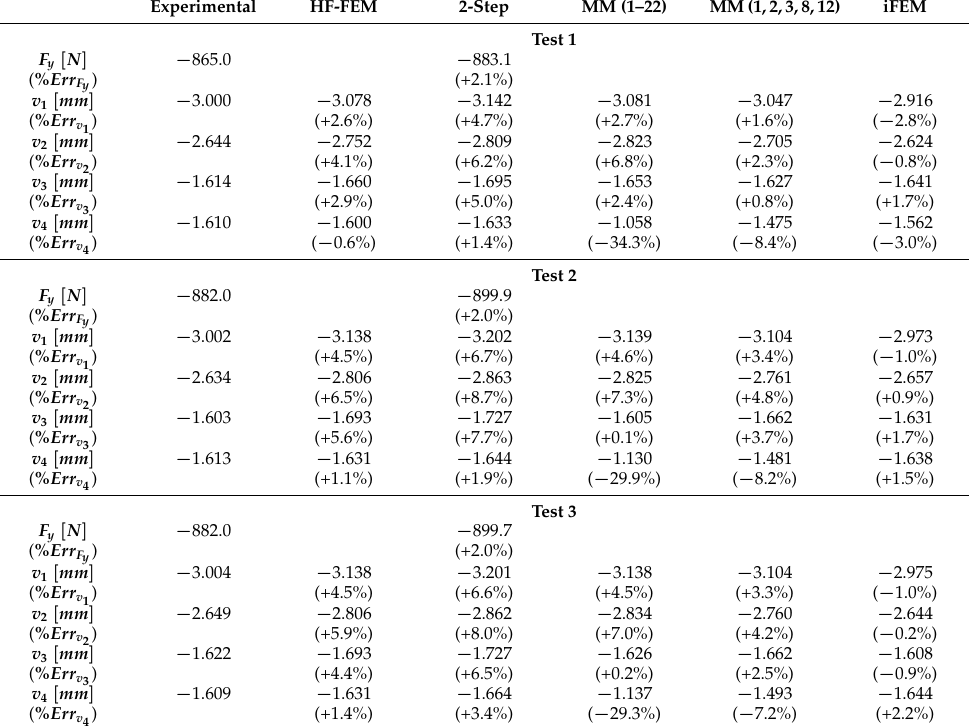
Figure 9. LVDTs’ configuration—The location of the four LVDTs ( v 1 − 4 ) on the surface of the panel are shown. All dimensions are expressed in [mm]. Table 2. Shape sensing and load identification results for the stiffened panel. In parenthesis, the per- centage errors with respect to the experimental values are reported. The errors are computed considering the absolute value of the